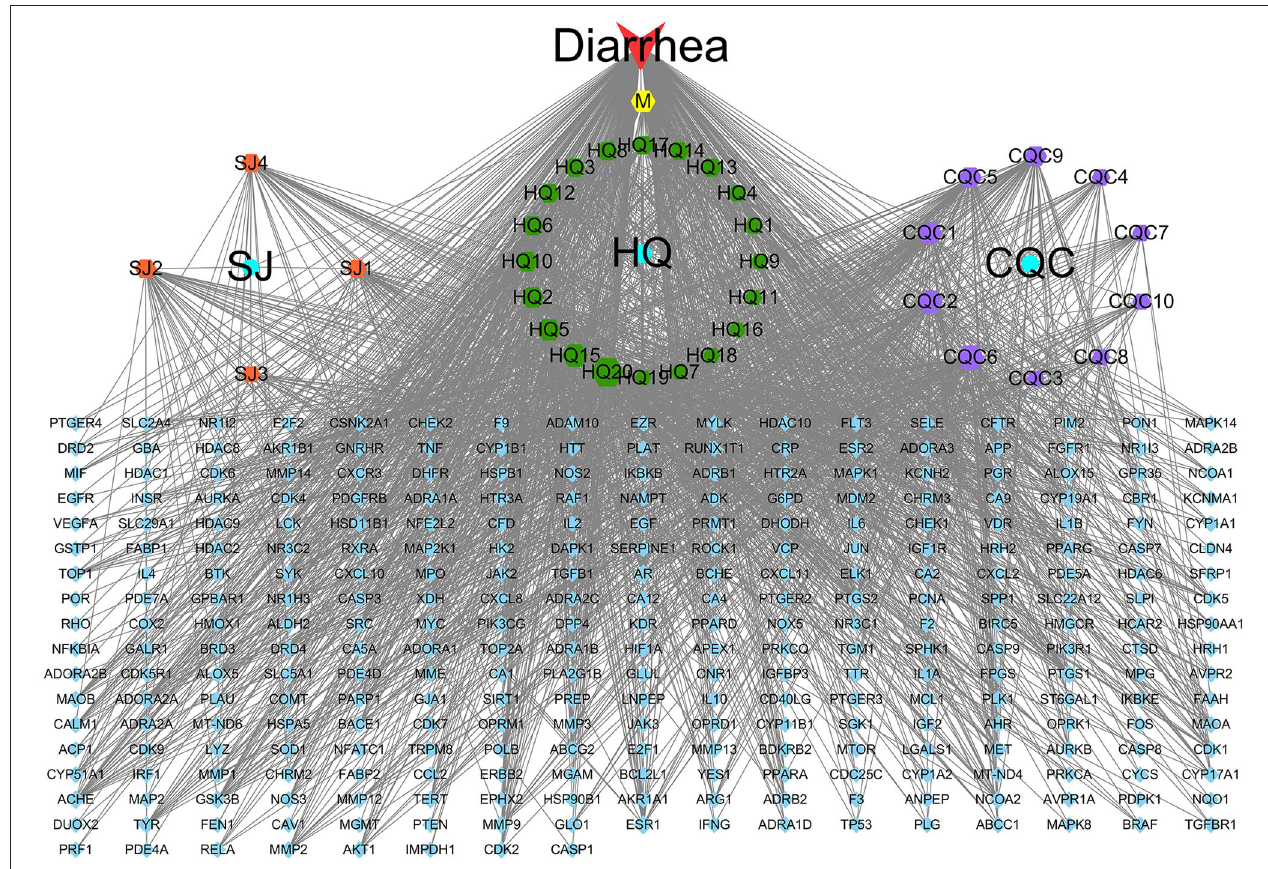
FIGURE 3 | The “QJC-component-target-diarrhea” network. The yellow hexagon represents stigmasterol; the blue circle represents Zingiber officinale Roscoe (SJ), Astragalus propinquus Schischkin (HQ), and Plantago asiatica L. (CQC); the blue parallelogram represents overlapping genes; the orange parallelogram represents components of SJ; the green hexagon represents components of HQ; and the purple hexagon represents components of CQC. The node size represents the size of the